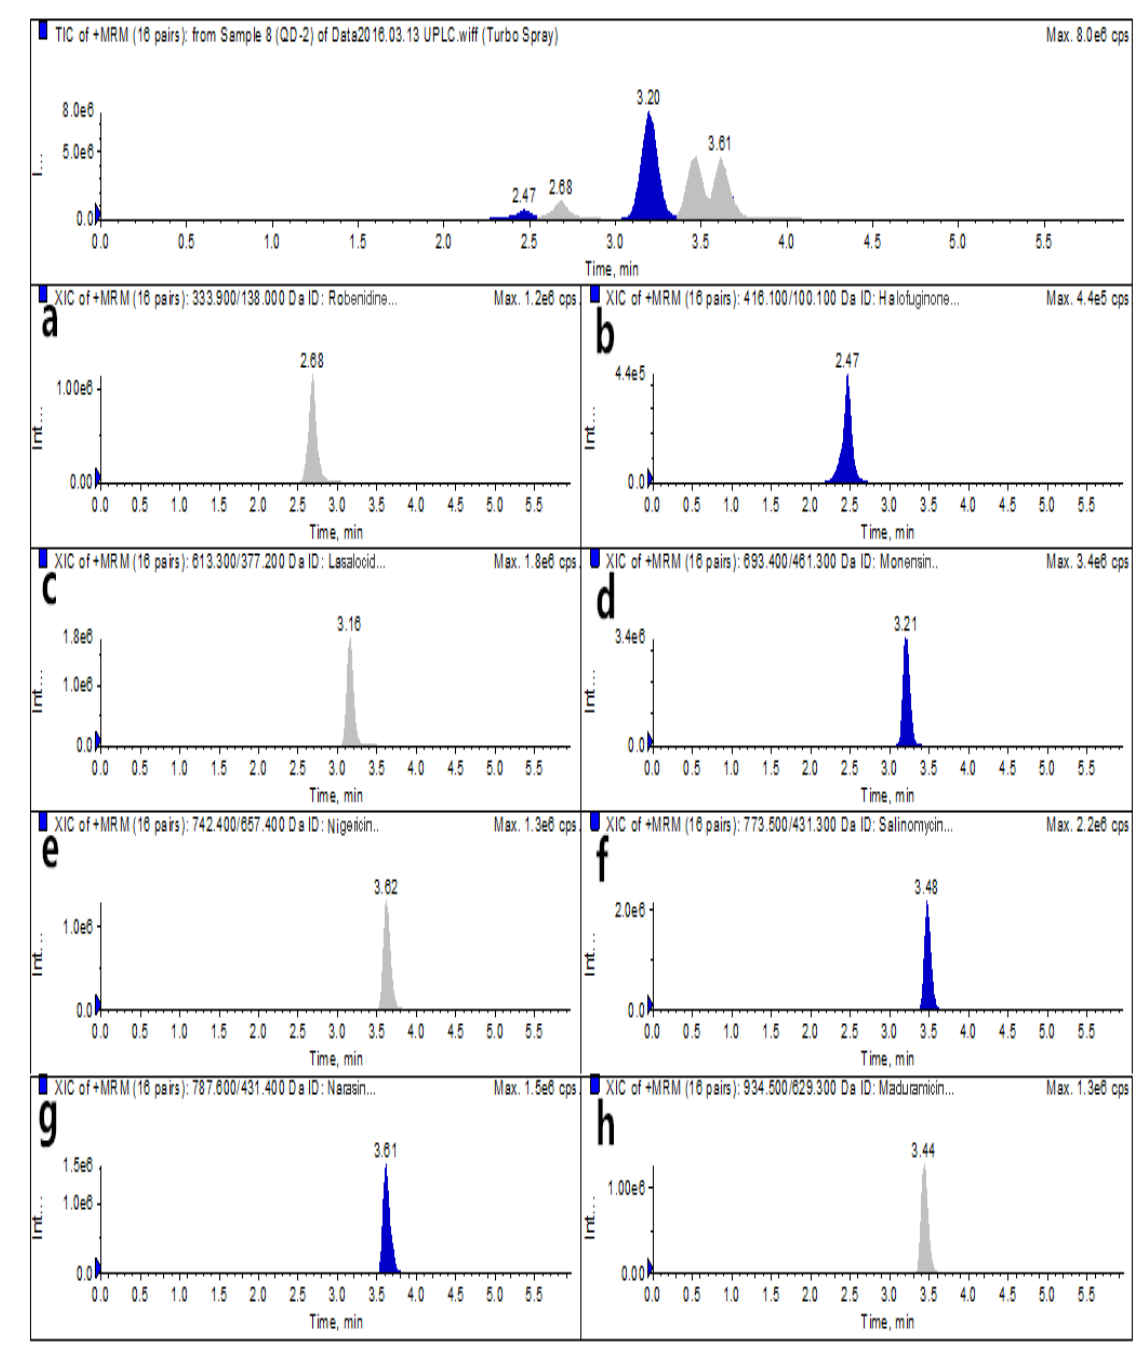
Figure 5. UPLC–MS / MS TICs and XICs ( a – h : ROB, HAF, LAS, MON, NIG, SAL, NAR, and MAD) of a Figure 5. UPLC–MS/MS TICs and XICs ( a – h : ROB, HAF, LAS, MON, NIG, SAL, NAR, and MAD) of blank egg sample spiked with ROB and HAF at 25.0 µ g / kg, MON at 37.5 µ g / kg, MAD at 60.0 µ g / kg, a blank egg sample spiked with ROB and HAF at 25.0 µg/kg, MON at 37.5 µg/kg, MAD at 60.0 µg/kg, and LAS, NIG, SAL, and NAR at 15.0 µ g / and LAS, NIG, SAL, and NAR at 15.0 µg/kg.